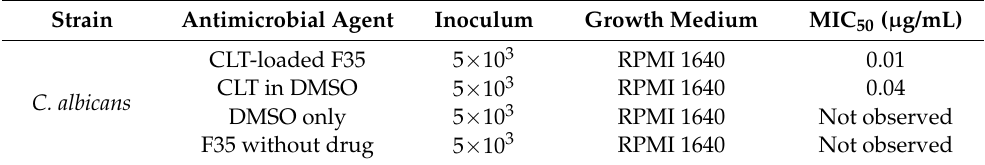
Table 2. MIC 50 of C. albicans with CLT in different formula.